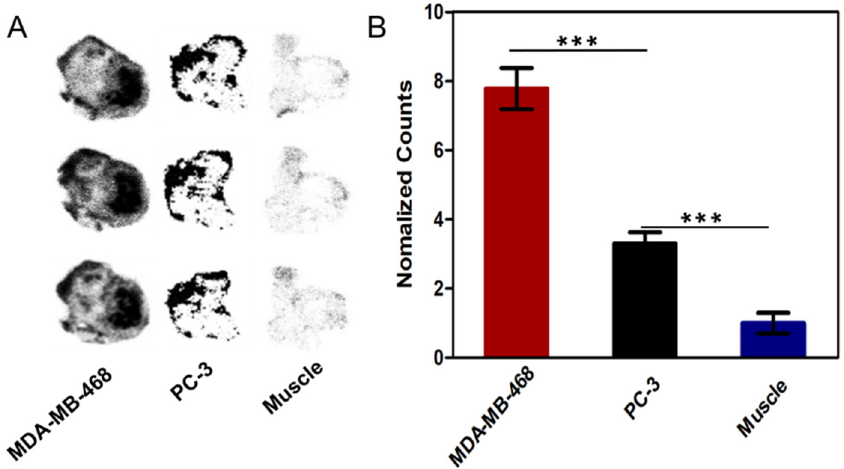
Figure 6. ( A ) Autoradiography analysis of [ 18 F] SF-AAN in tumors (MDA-MB-468, PC-3) and muscle at 30 min post injection. ( B ) Quantitative analysis of the radioactivity in tumors and muscle by ImageJ software. Error bar represents standard deviation ( n = 3). *** denotes p < 0.001.